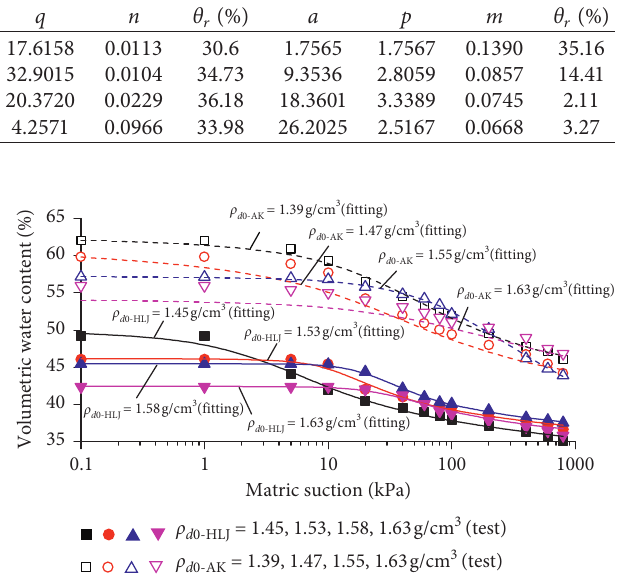
Figure 9: The fitting curves using Gardner model under different initial dry densities.